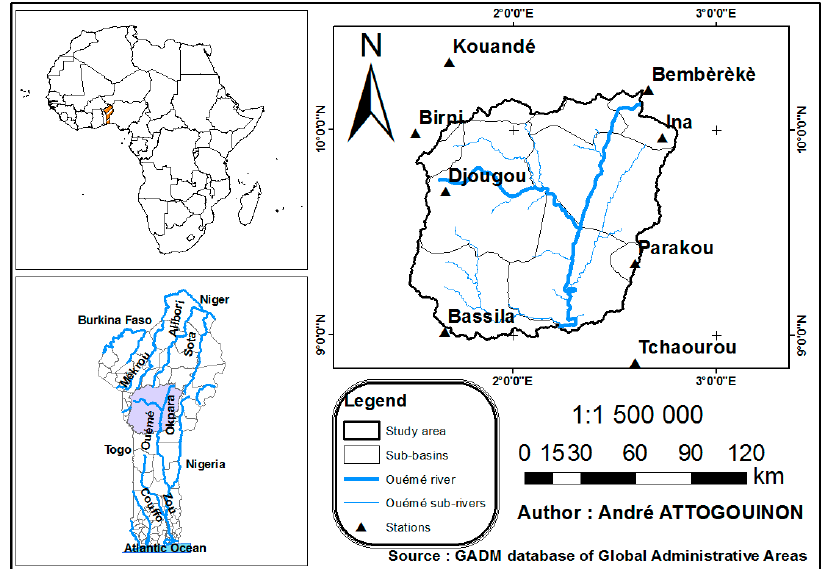
Figure 1. Location of the study area.